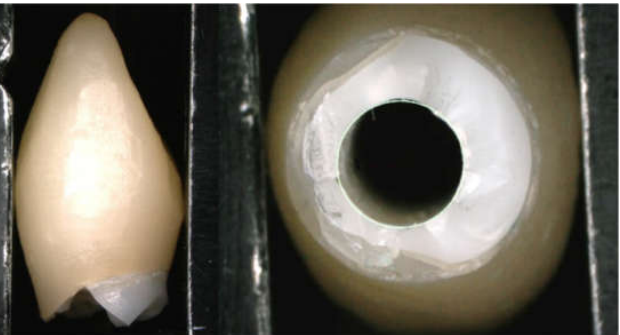
Figure 7. Fracture mode in the ASC-Zr group (a relatively horizontal pattern with a buccal fracture surface away from the implant platform).